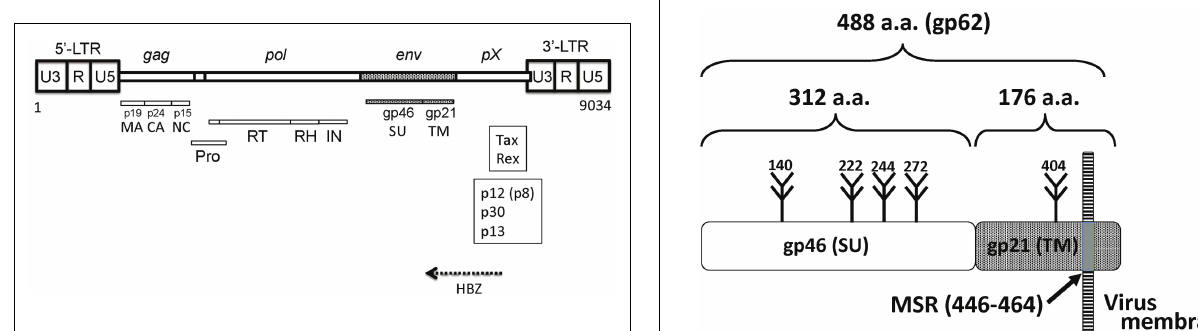
FIGURE 1 | Structure of HTLV-1 genome. The gag gene encodes the matrix (MA), capsid (CA), and nucleocapsid (NC) proteins.The pol gene encodes reverse transcriptase (RT), RNase H (RH), and integrase (IN).The pX region encodes p13, p12, p30, etc. HBZ is encodes by the anti-sense frame of the provirus.